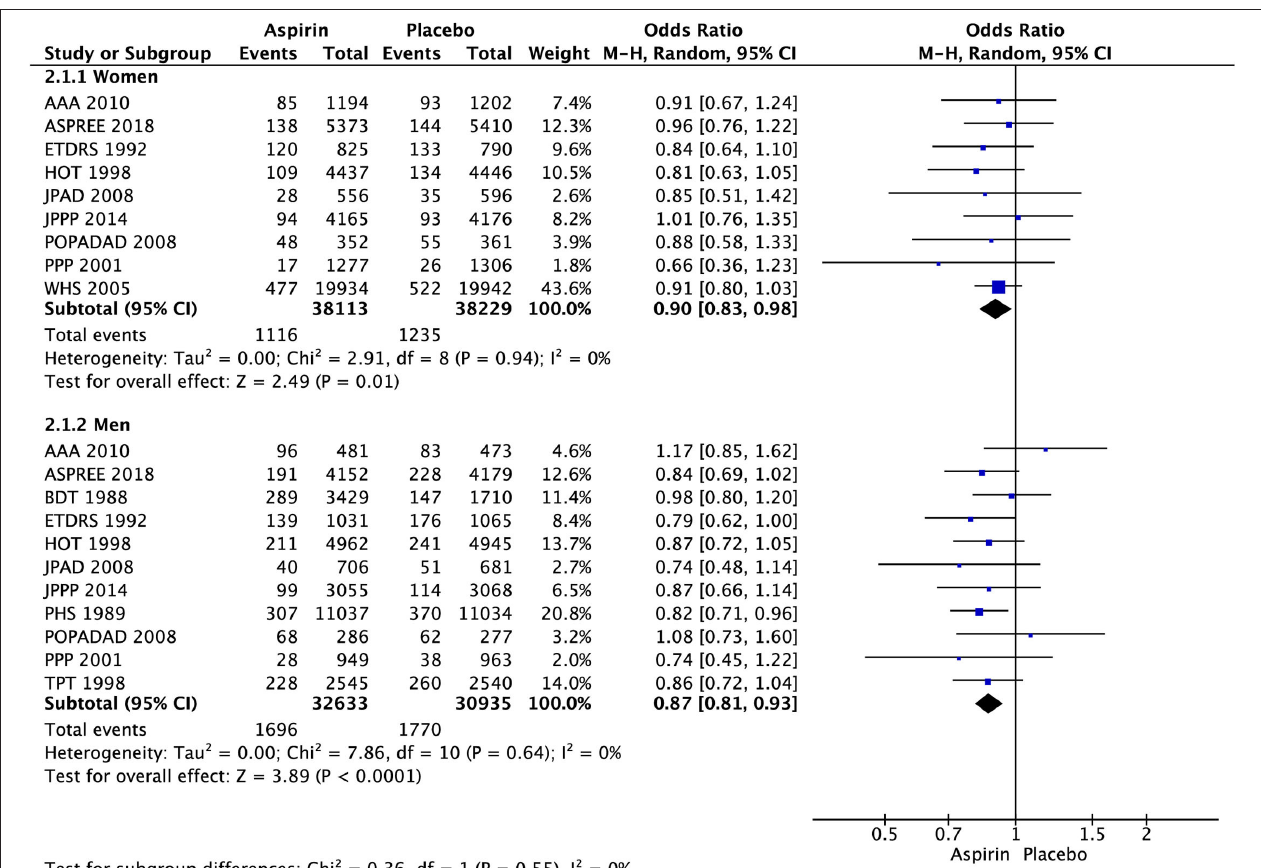
FIGURE 2 | Major cardiovascular events in women and men taking aspirin or